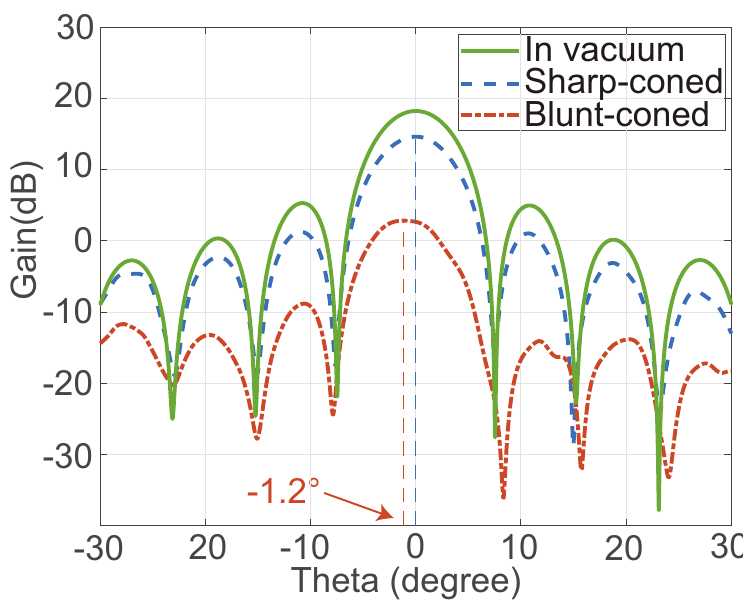
Figure 4. The radiation pattern of the antenna in plasma for different vehicle shapes and in